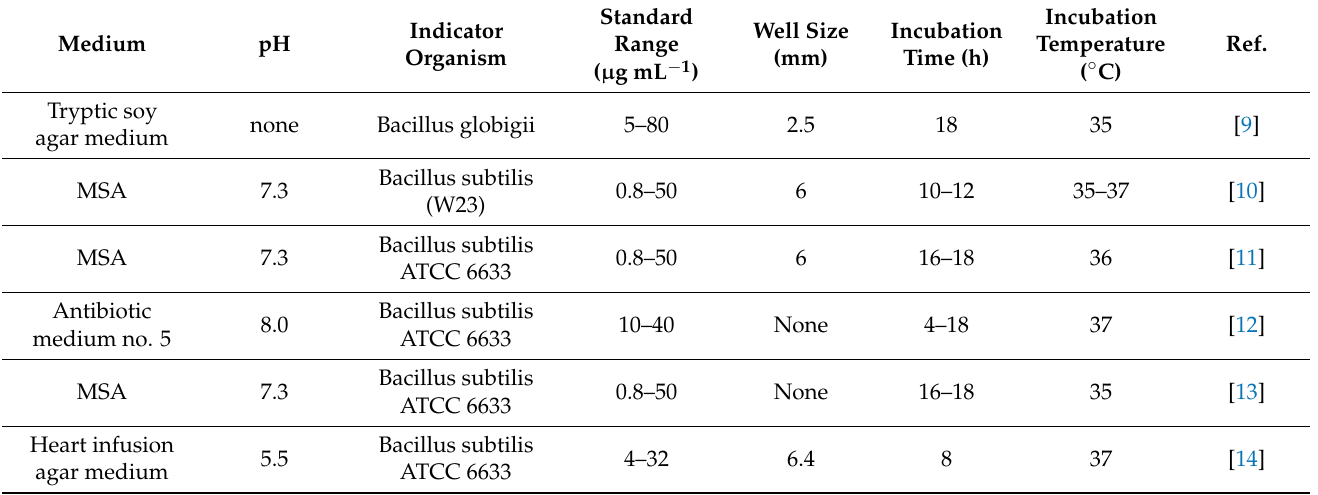
Table 1. Bioassay for